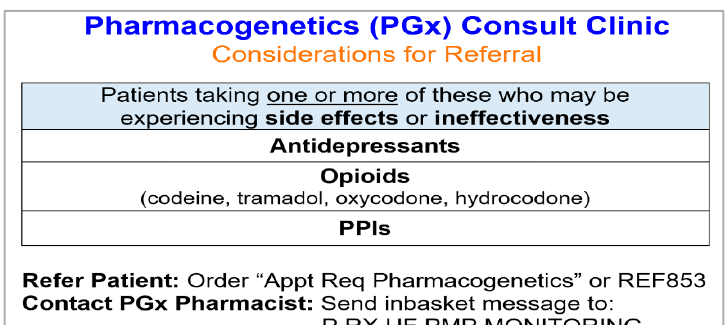
Figure 1. Clinical workflow of the pharmacogenetics consult clinic.